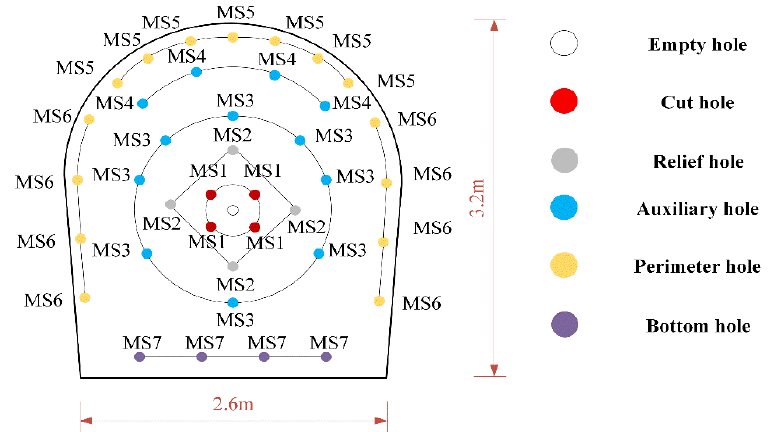
Figure 1. Geographic location map.